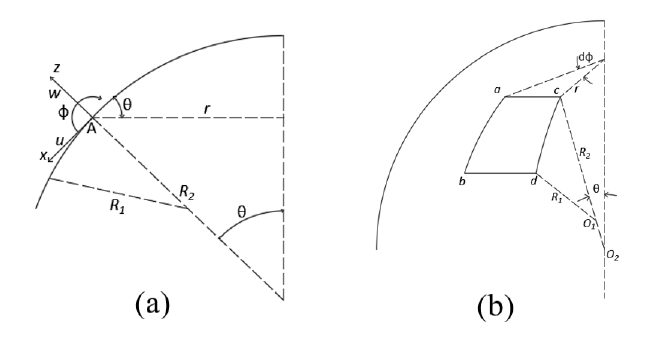
Figure 3. ( a ) Geometric parameters; ( b ) infinitesimal element of the